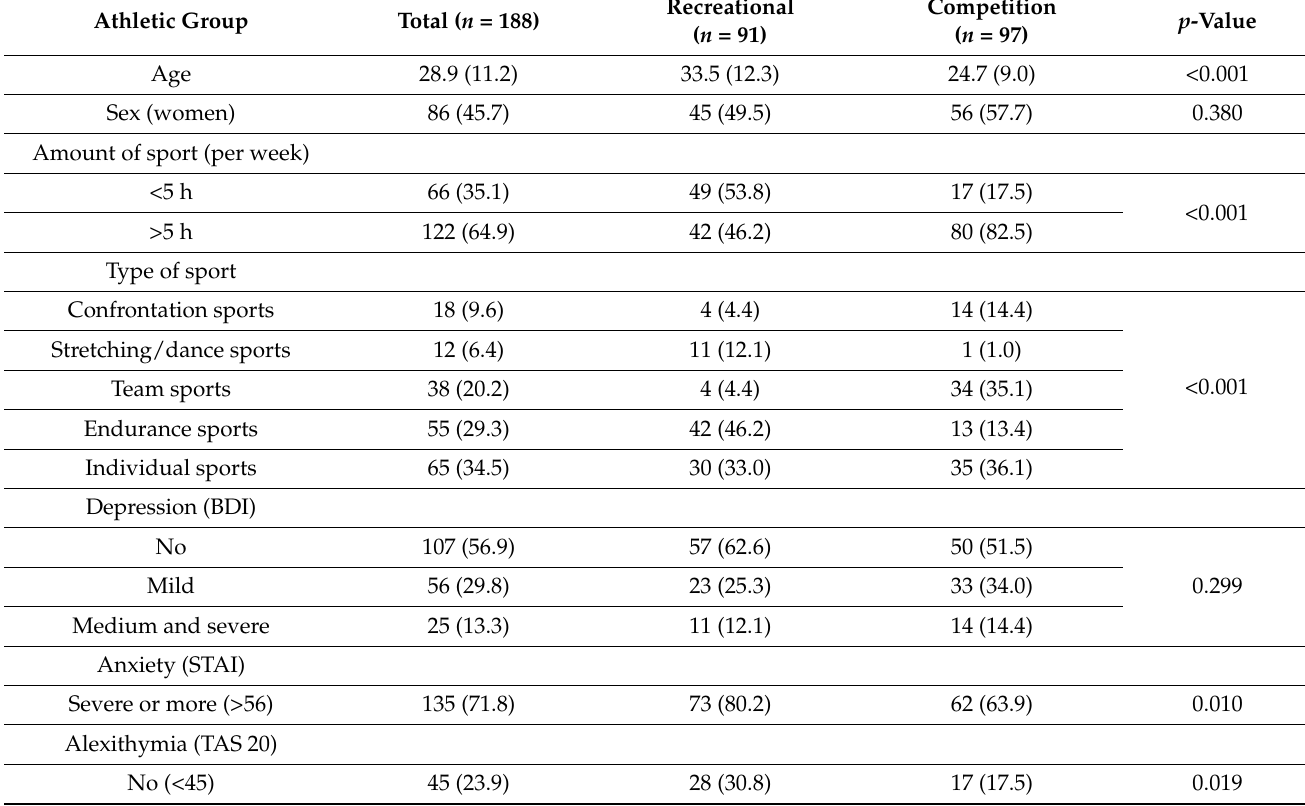
Table 1. Baseline demographic, mental and sports characteristics ( n =